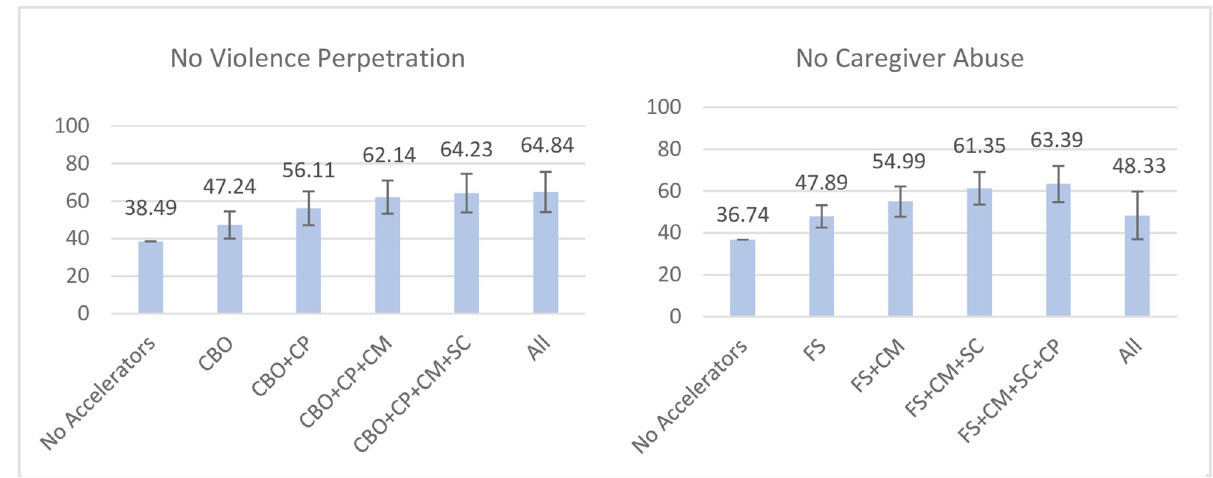
Fig 4. Accelerator combinations leading to the strongest changes in adjusted probabilities for each violence-related outcome. Figure scales adjusted based on range of outcome values. CBO = Access to community-based organisations, SC = Living in a Safe Community, CP = Caregiver Praise, FS = Food security, CM = Caregiver Monitoring. 95% confidence intervals